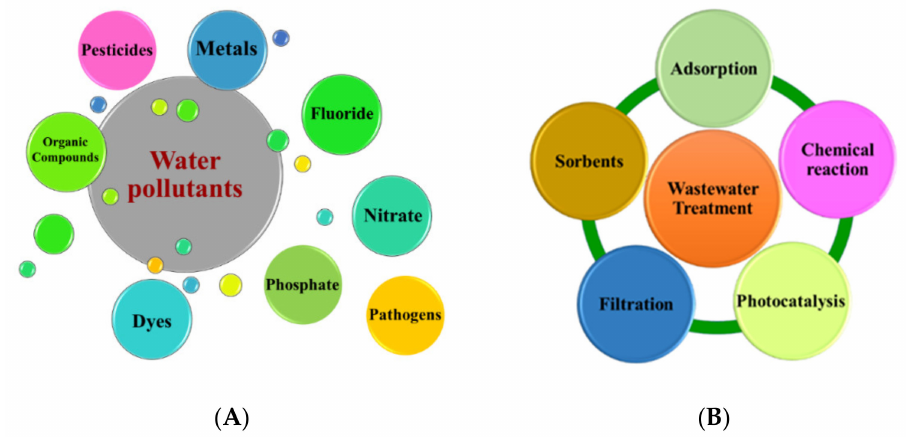
Figure 6. Common pollutants found in water and the treatment processes. ( A ) Common pollutants present in water. ( B ) Treatment approaches used for wastewater using